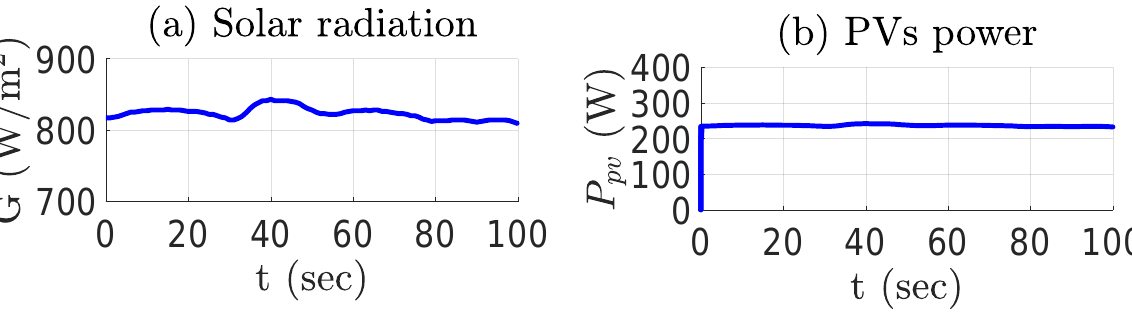
Figure 2. Simulation: ( a ) Solar radiation, ( b ) PV